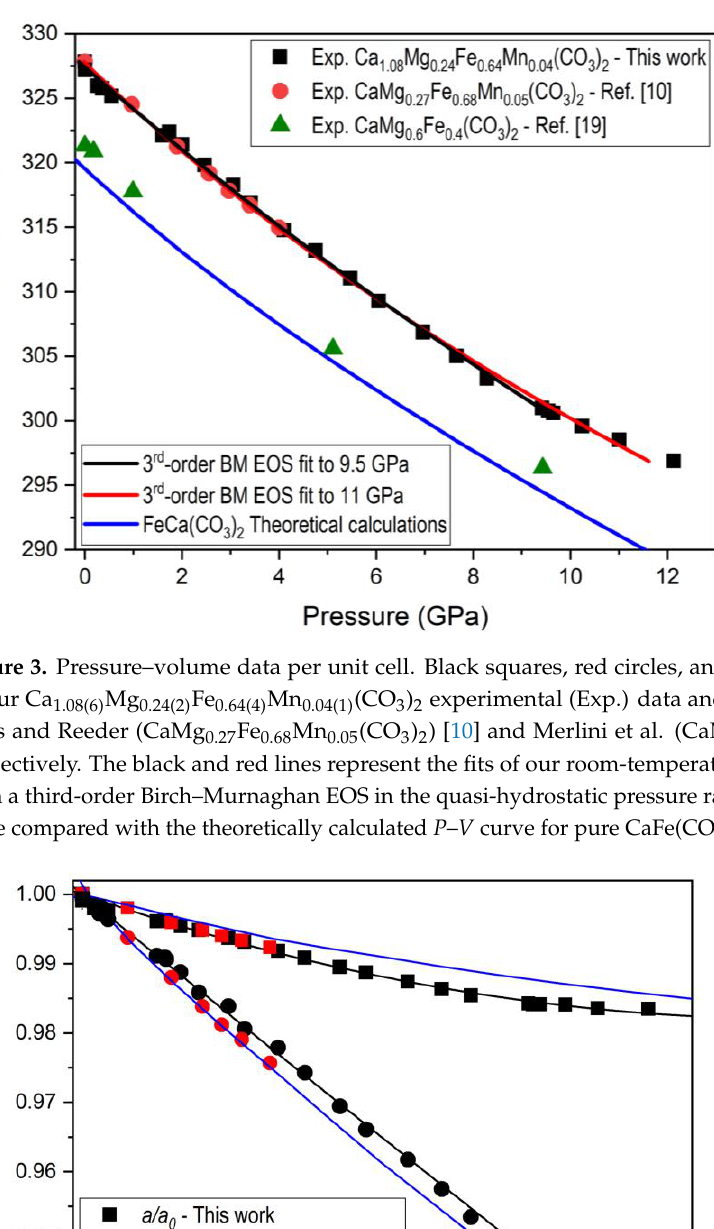
Figure 5. c / a axes ratio as a function of pressure. Black squares and red circles refer to our Ca 1.08(6) Mg 0.24(2) Fe 0.64(4) Mn 0.04(1) (CO 3 ) 2 experimental data and the reported data by Ross and Reeder [10], respectively. Results from DFT calculations for pure CaFe(CO 3 ) 2 ankerite are represented as a blue line. Figure 4 shows that the compressibility of the a axis significantly decreases above 9 GPa, which could be caused by deviatoric stresses as a consequence of the loss of hydro- staticity of the methanol–ethanol pressure-transmitting medium [30]. At pressures higher than 12.6 GPa, additional diffraction peaks progressively appear (Figure 2). We tried to index the XRD pattern above that pressure, assuming the possibility of phase coexistence